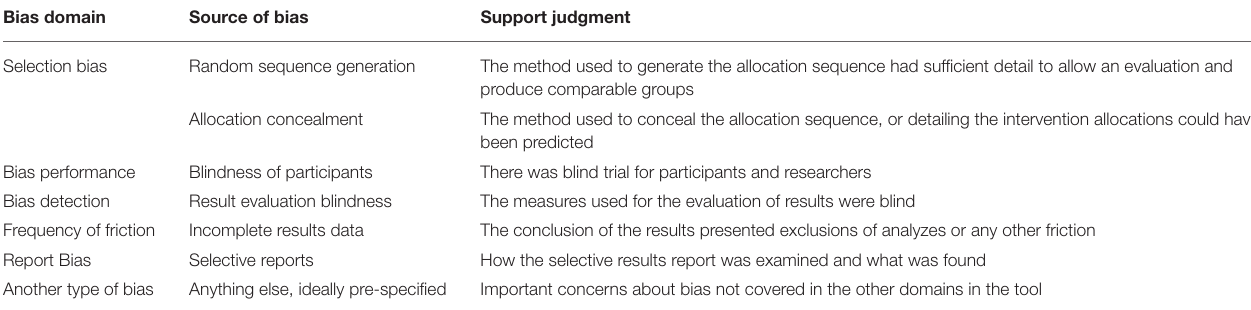
TABLE 1 | Risk of bias evaluation of included